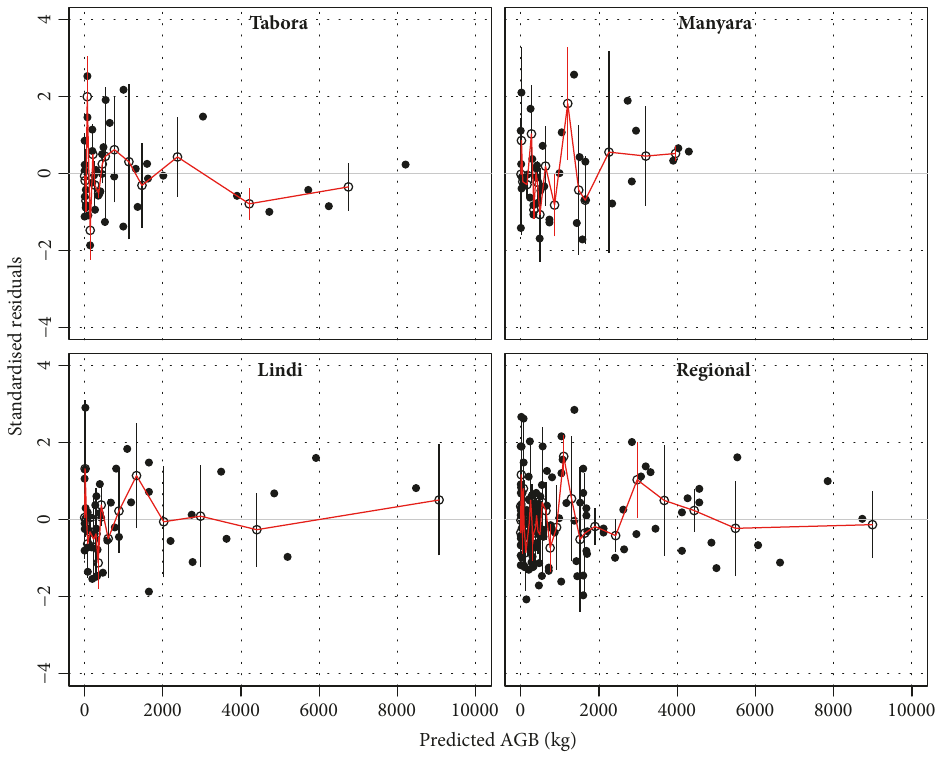
Figure 8: Residual plots of selected sites and regional aboveground biomass